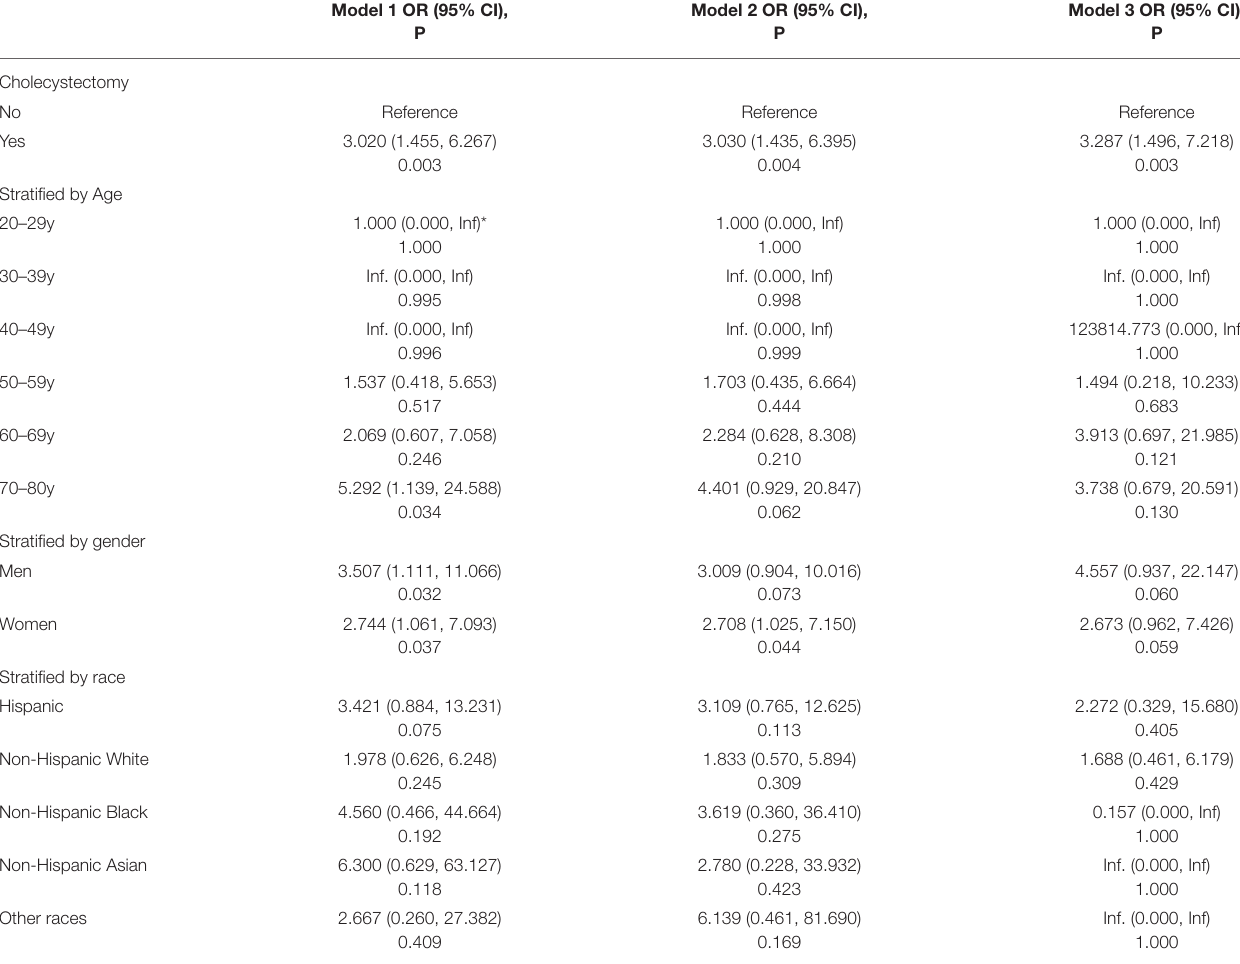
TABLE 4 | Associations between cholecystectomy and liver cirrhosis after propensity score matching ( n = 978), NHANES 2017–2018.